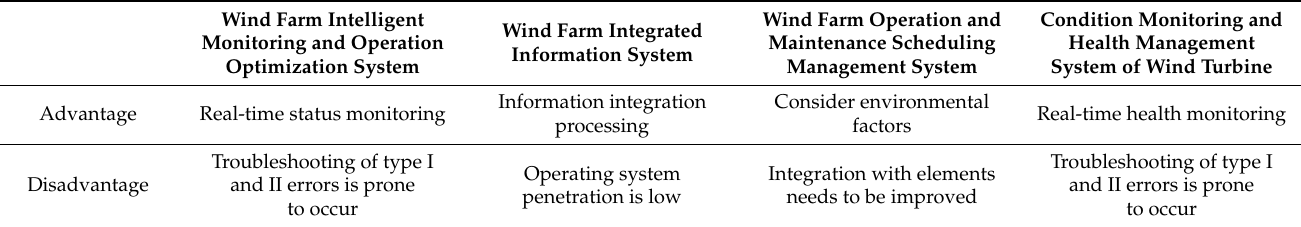
Table 2. The advantages and disadvantages of the smart operation and maintenance management platform for wind farms